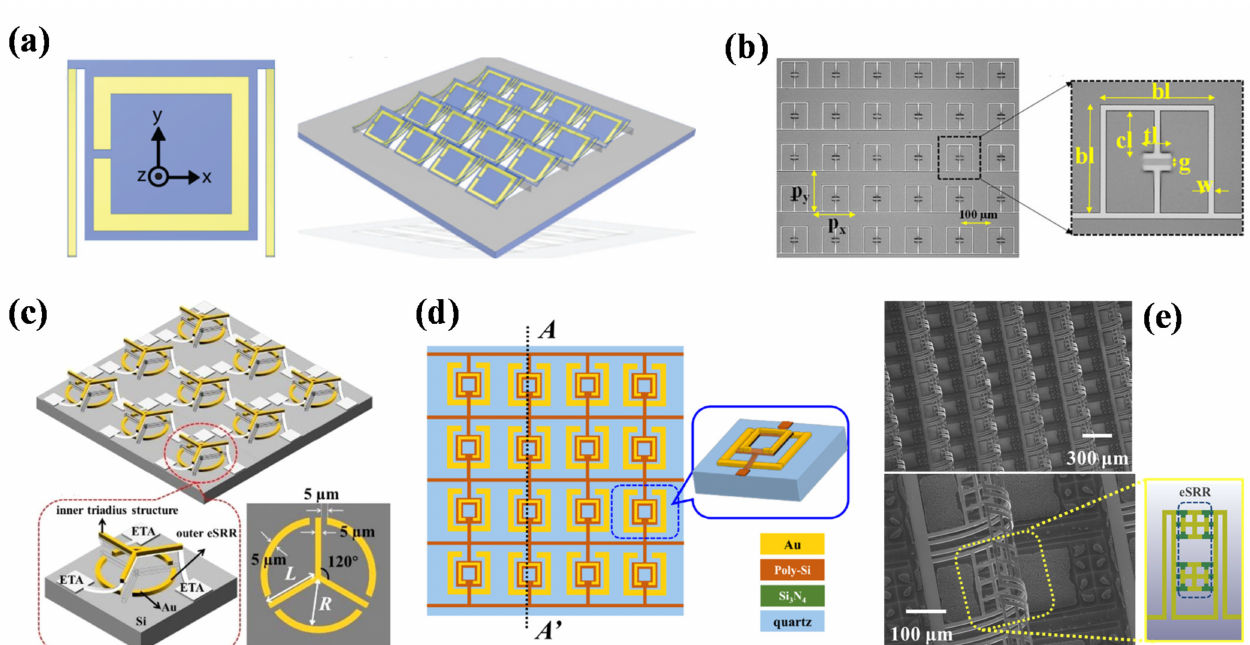
Figure 2. ETA-based vertical tuning methods of metamaterials: ( a ) schematic of thermally tunable split-ring resonators (SRR) based on the pre-stressed metamaterial [58]; ( b ) optical microscopy image of the eSRR based on metamaterial microarray [59]; ( c , d ) schematic of MEMS-based tunable THz metamaterial and unit cell by using ETA vertical tuning platforms [60,61]; ( e ) scanning electron microscope (SEM) images of eSRR–WCM array and unit cell